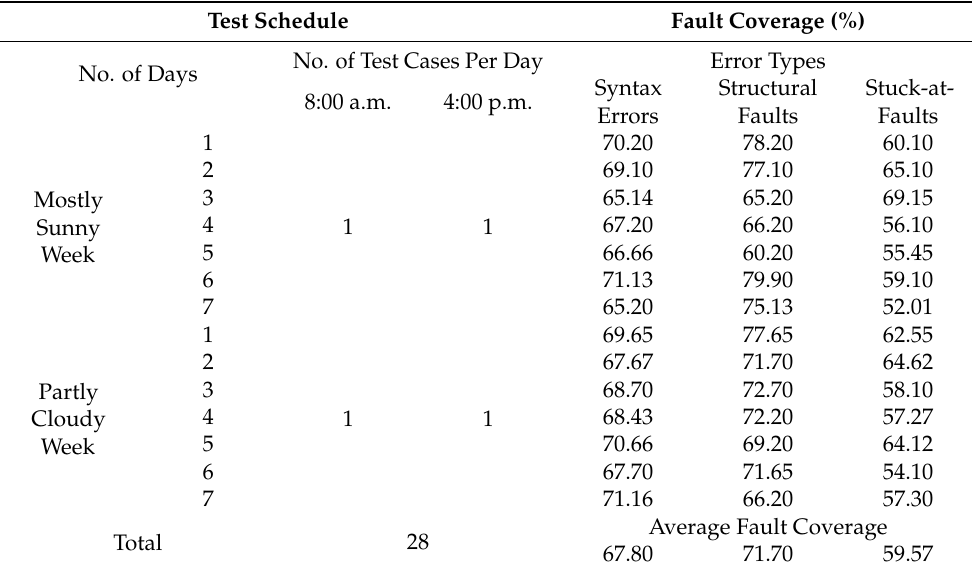
Table 2. Experimental results regarding our JTAG boundary scan and flying probe in-circuit tester (FPICT) procedure